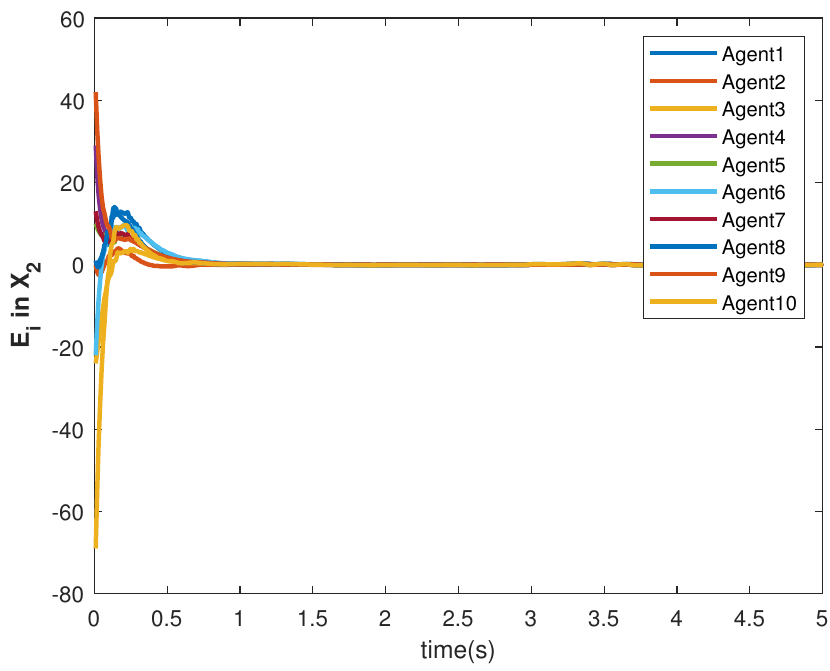
Figure 12. Consensus error E 2 in state X 1 of